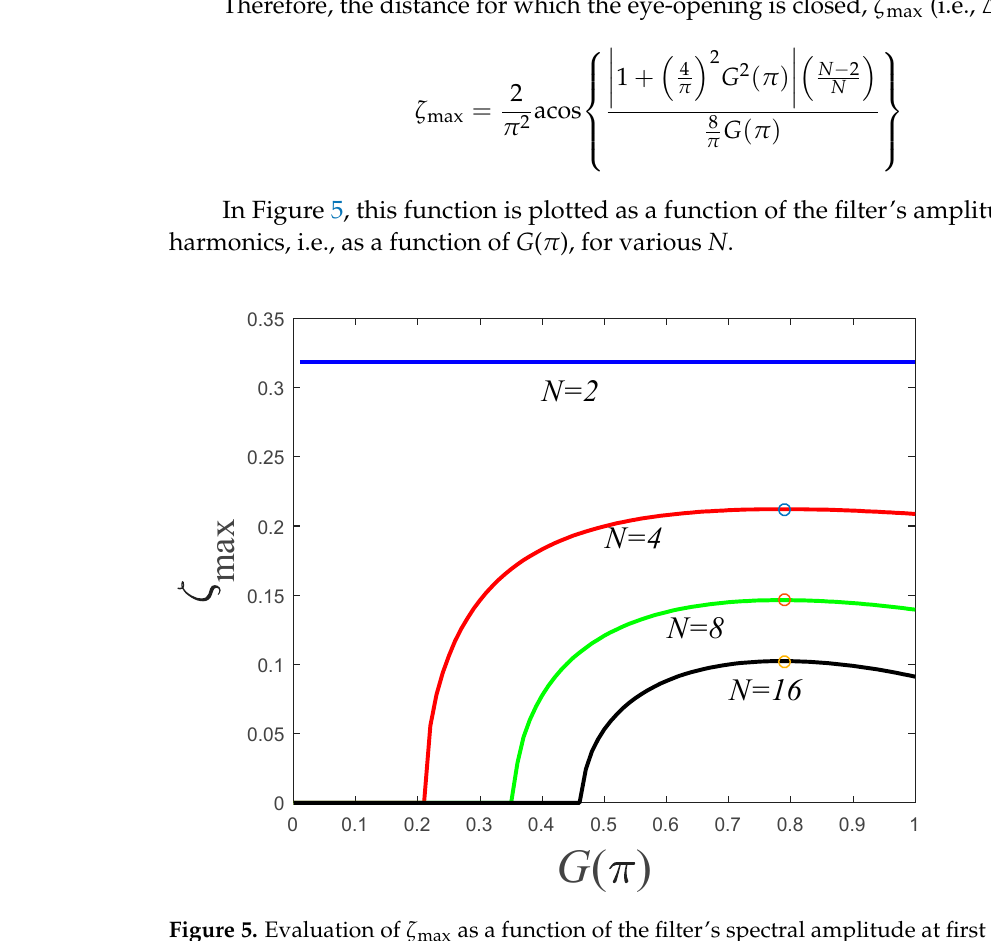
Table 1. Evaluation of Equation (22) for different Q-values.